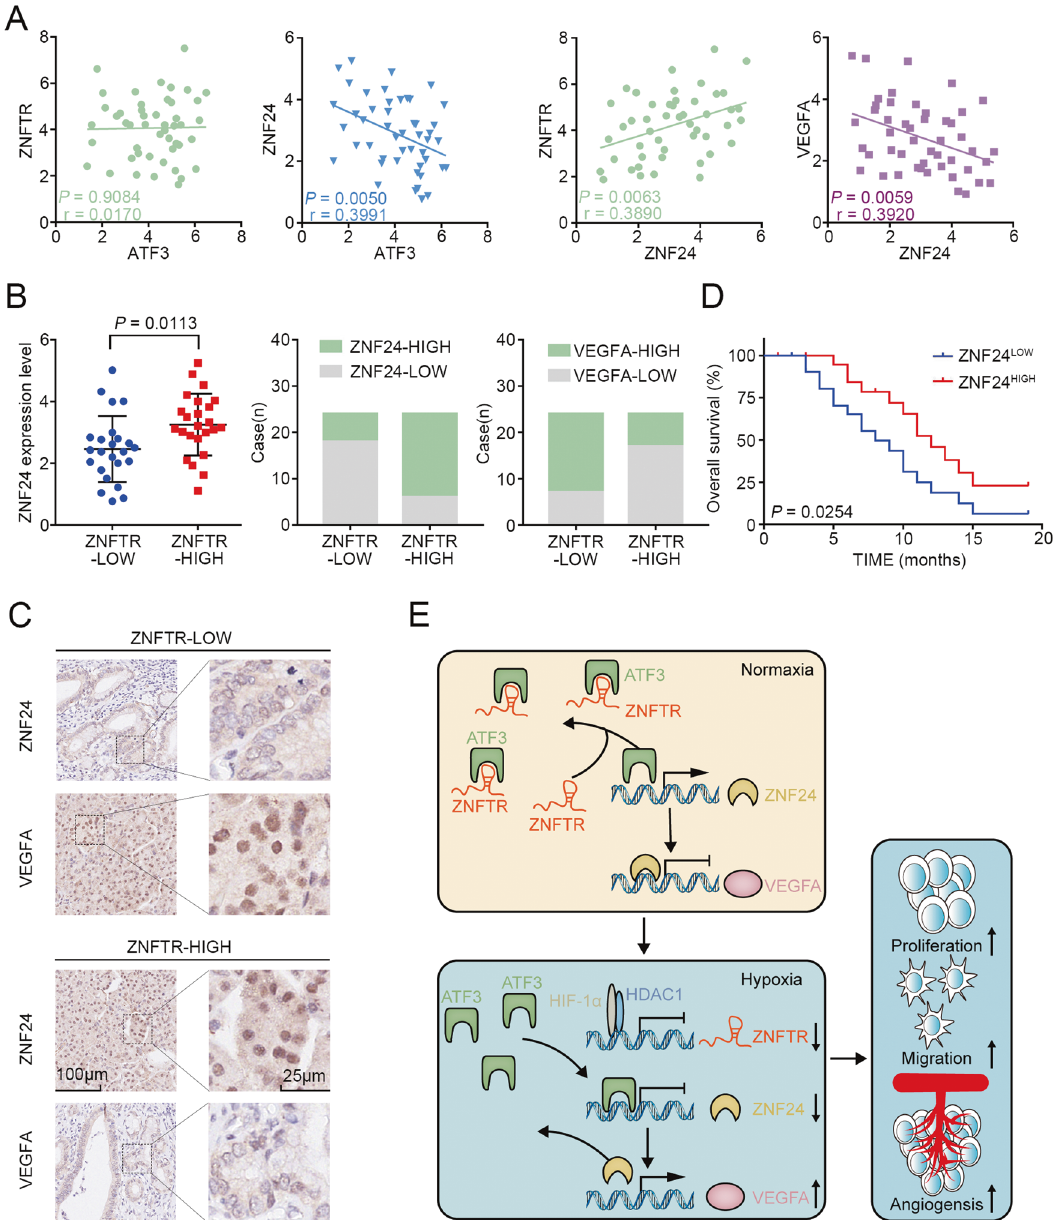
correlation analysis and chi -square test identi fi ed a positive association between ZNFTR and ZNF24 in the PC samples. The chi -square test identi fi ed a negative association between ZNFTR and VEGFA in the PC samples. C The expression level of ZNF24 and VEGFA was analyzed by immunohistochemistry (IHC) in the “ ZNFTR-HIGH ” or “ ZNFTR-LOW ” group. Forty-eight patients were separated into “ HIGH ” and “ LOW ” two groups according to the expression level of ZNFTR at the median. D Overall survival analysis in 48 patients with PC was shown by